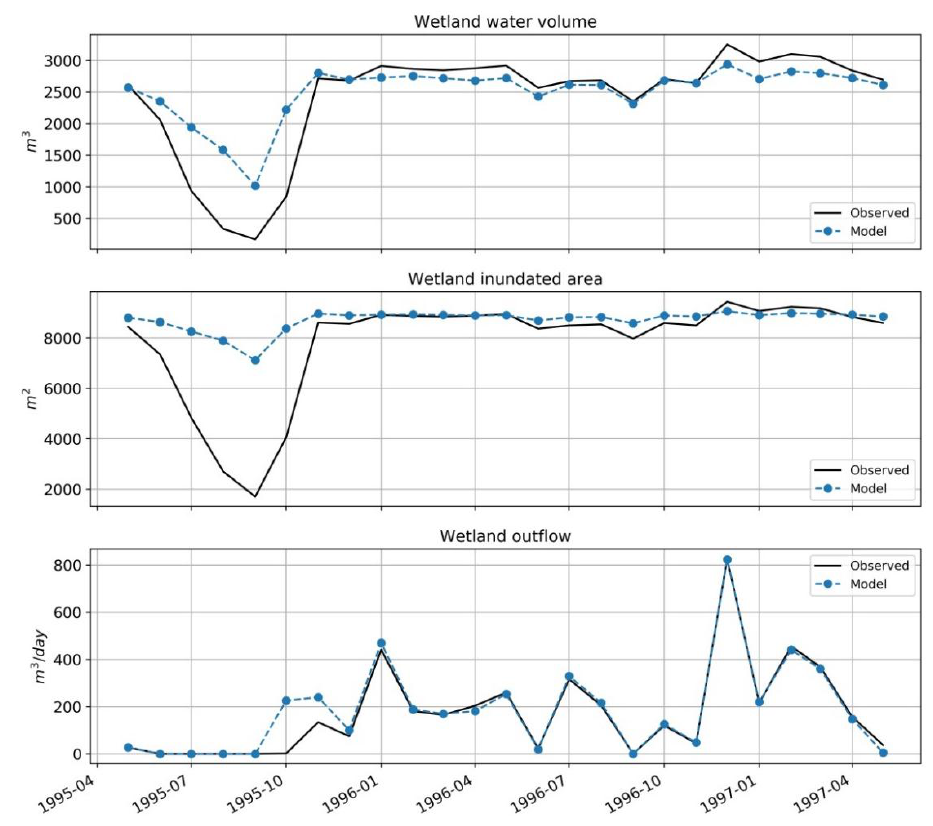
Figure 5. Comparison of monthly simulated and observed wetland volume (NSE = 0.68, R 2 = 0.89), inundated area (NSE = 0.15, R 2 = 0.9) and outflow (NSE = 0.93, R 2 = 0.93).